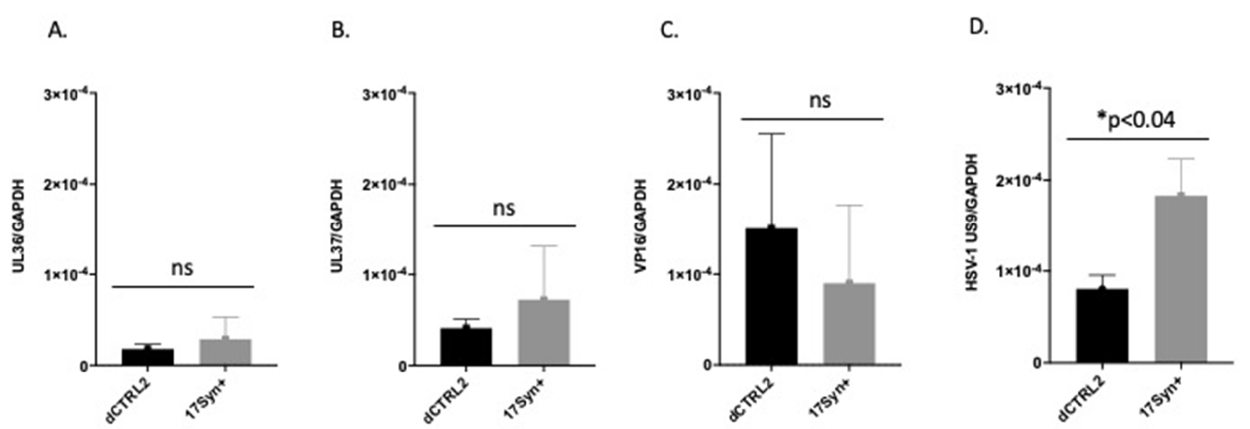
Figure 5. Us9 expression was significantly lower in ∆ CTRL2-infected rabbits at 5 days post-reactivation. Rabbit TG were isolated and RNA extracted as indicated in the methods section, and subsequently used for qRT-PCR to assess gene expression during latency for the wt and recombinant viruses. ( A ) Relative values for UL36 were normalized to rabbit GAPDH and are presented as normalized ratios for gene expression. ( B ) Relative values for UL37 were normalized to rabbit GAPDH and are presented as normalized ratios for gene expression. ( C ) Relative values for VP16 were normalized to rabbit GAPDH and are presented as normalized ratios for gene expression. ( D ) Relative values for Us9 were normalized to rabbit GAPDH and are presented as normalized ratios for gene expression. One-way ANOVA of independent samples was used to determine statistical significance between the mutant and wt ( n = 5). * indicates a significant reduction in luciferase expression between the LTE and LTE/CTCF